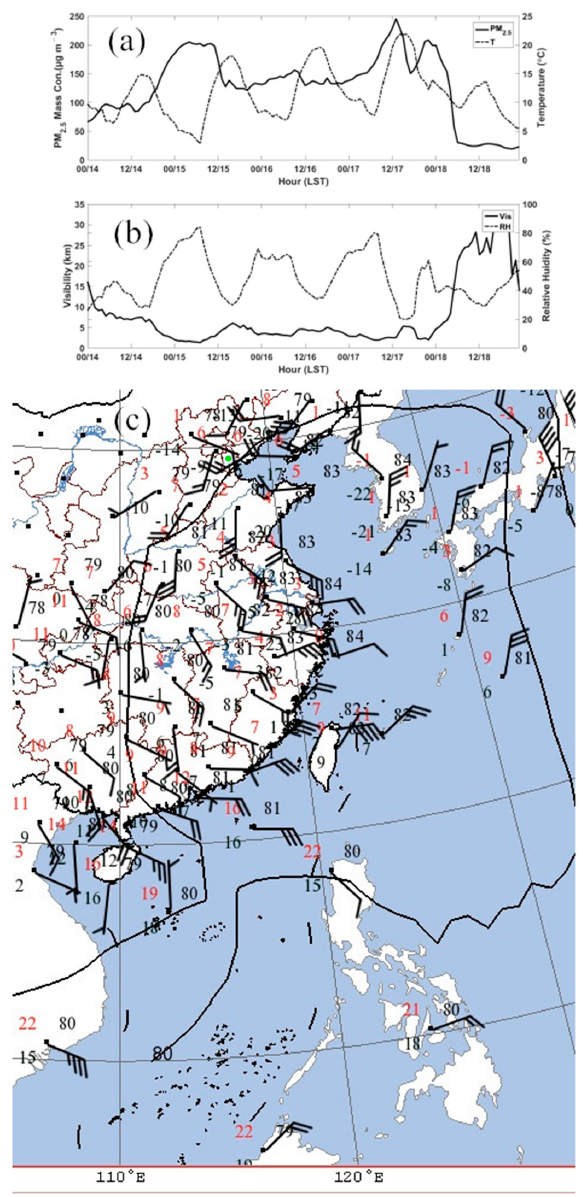
Figure 9. Temporal variations of ( a ) PM 2.5 mass concentration, temperature, ( b ) visibility, and relative humidity from 0000 LST 16 March to 2300 LST 18 March, 2016. ( c ) The contour chart and observations of meteorological parameters at 925 hPa at 0800 LST 15 March obtained from CMA (The green dot denotes the Meteorological Observation Station in